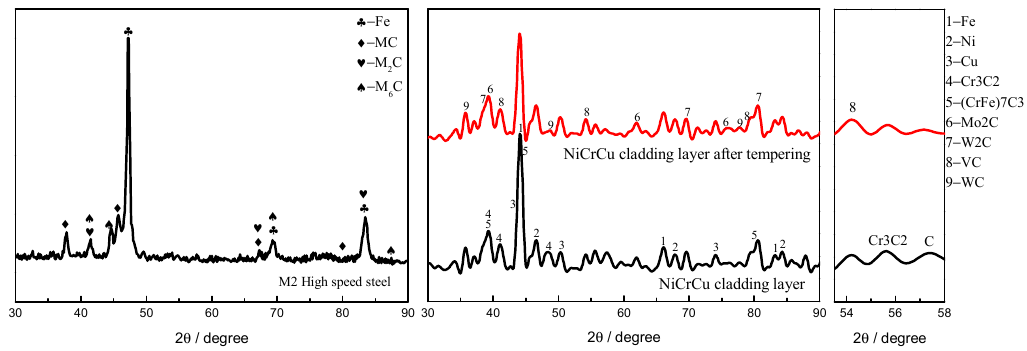
Figure 4. XRD patterns of quenched M2 high-speed steel and cladding layer.